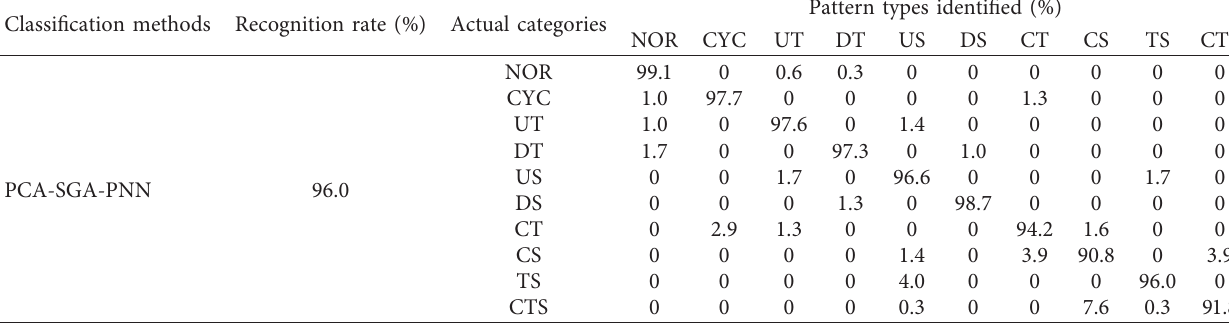
Table 2: Test results of quality abnormality identification model. Classification methods Recognition rate (%) Actual